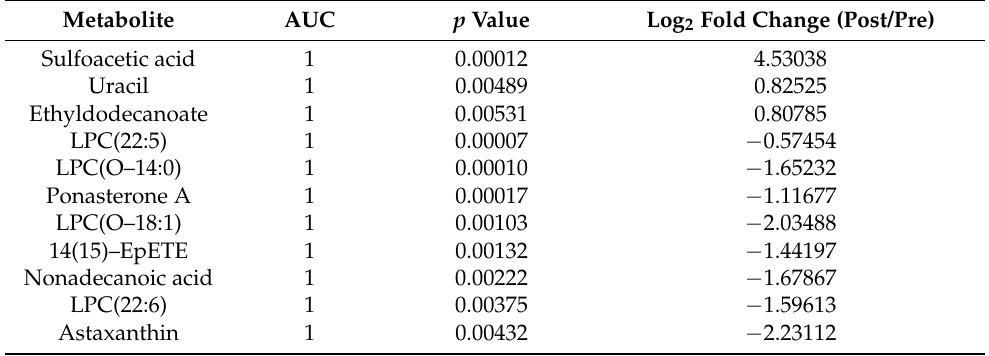
Table 2. Potential metabolite biomarkers for pubertal molt in serum of S. paramamosain .